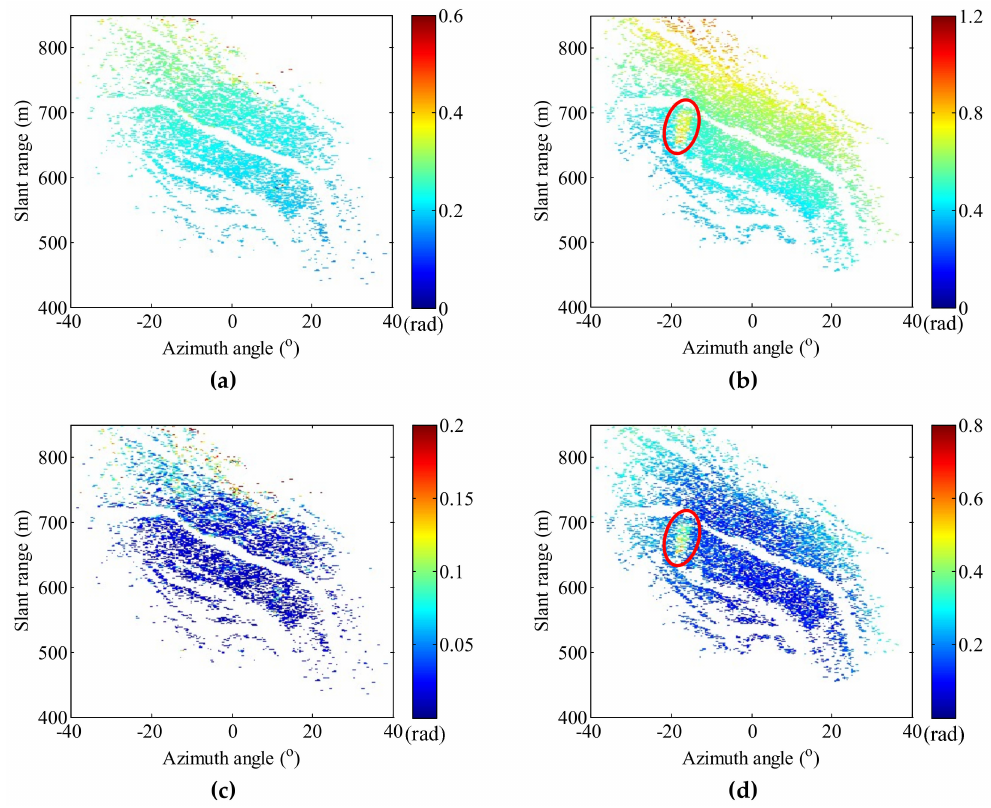
Figure 11. Phase deviation maps. Before APC: ( a ) Group A and ( b ) Group B. After APC with the conventional method: ( c ) Group A and ( d ) Group